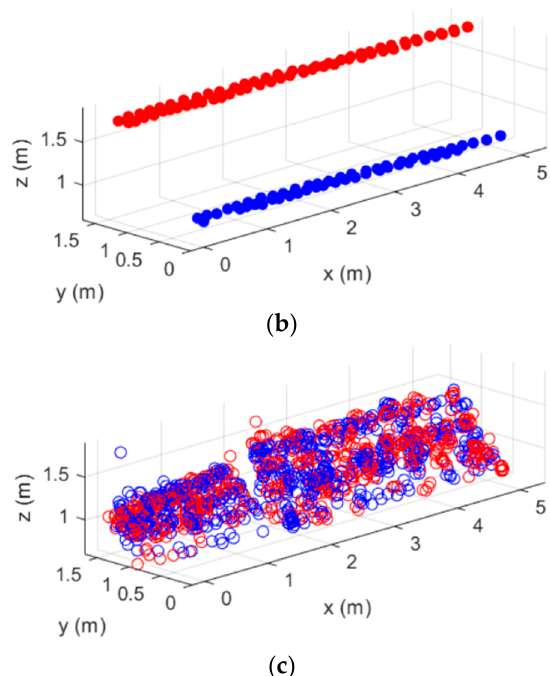
Figure 5. ( a ) Scanning area; ( b ) rover modules positions and ( c ) point cloud retrieved from a round trip scanning path.